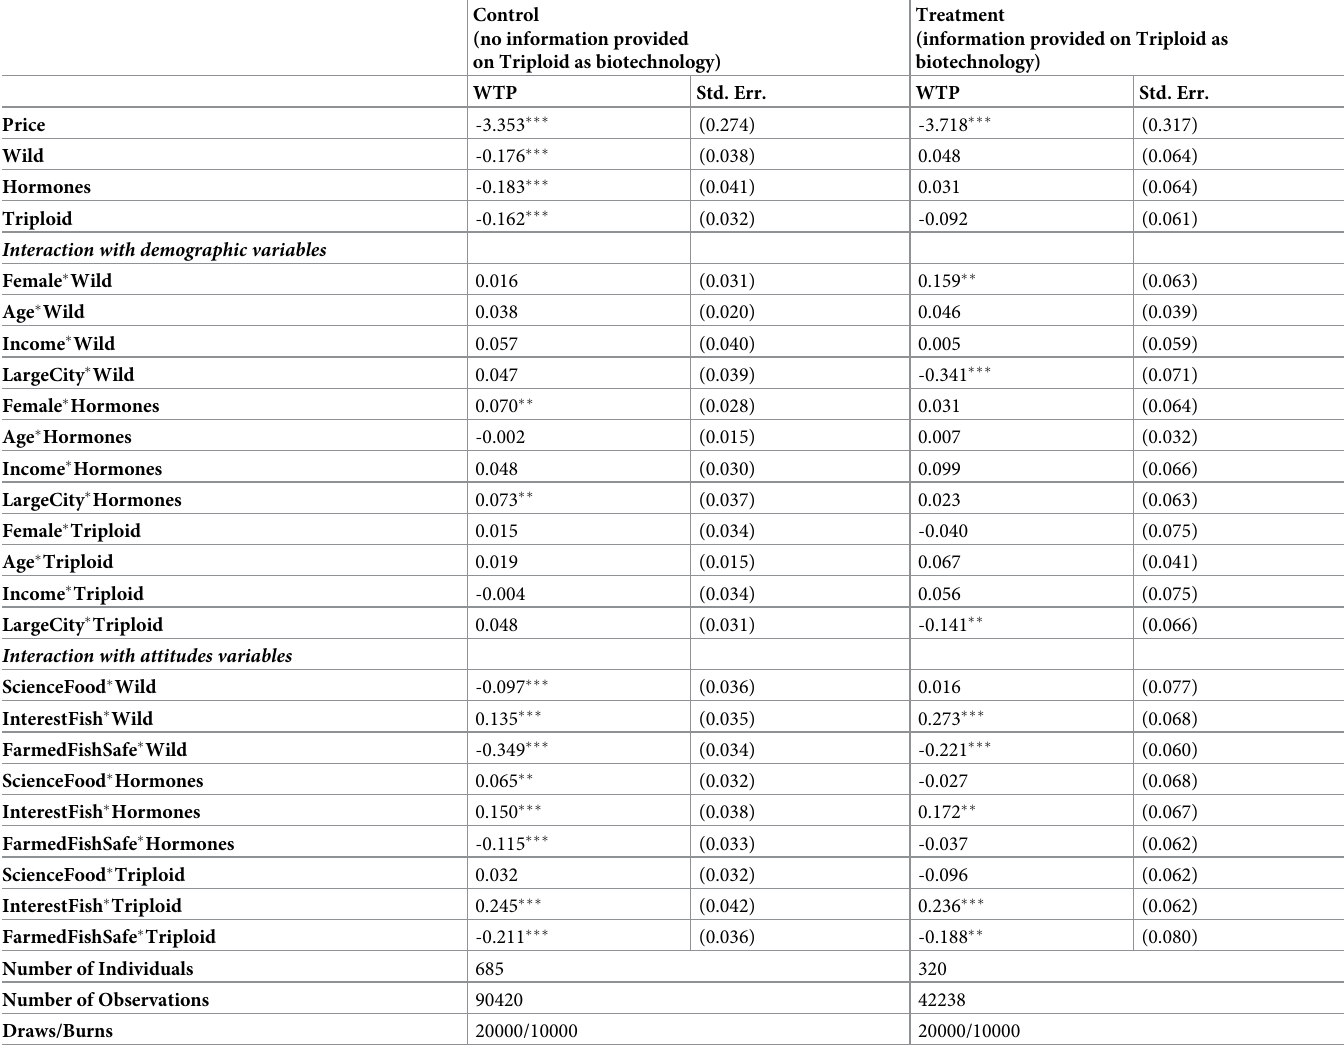
Table 4. Willingness-to-pay (WTP) estimates: Mean coefficients in